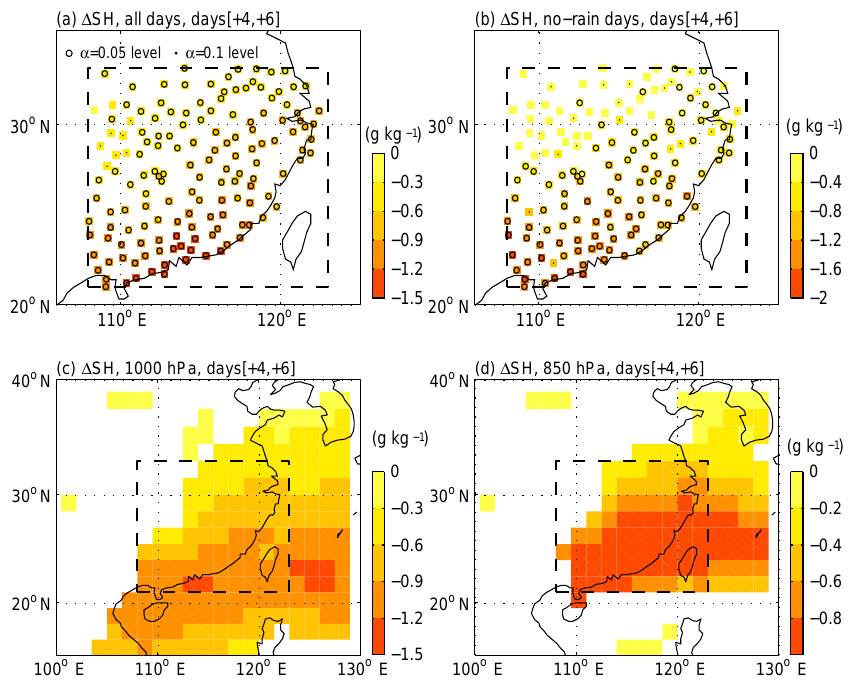
Figure 8. Spatial distribution of the observational specific humidity anomalies ( (cid:49) SH) during days [ + 4, + 6] as estimated from all available days (a) and no-rain days (b) . The spatial distributions of the ERA-Interim (cid:49) SH at 1000hPa (c) and 850hPa (d) during days [ + 4, + 6]. Only the significant values (above the 0.05 level) are